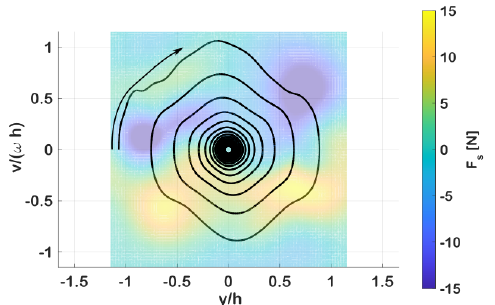
Figure 14. Interpolated sloshing force map and trajectory of sloshing force for tank cell